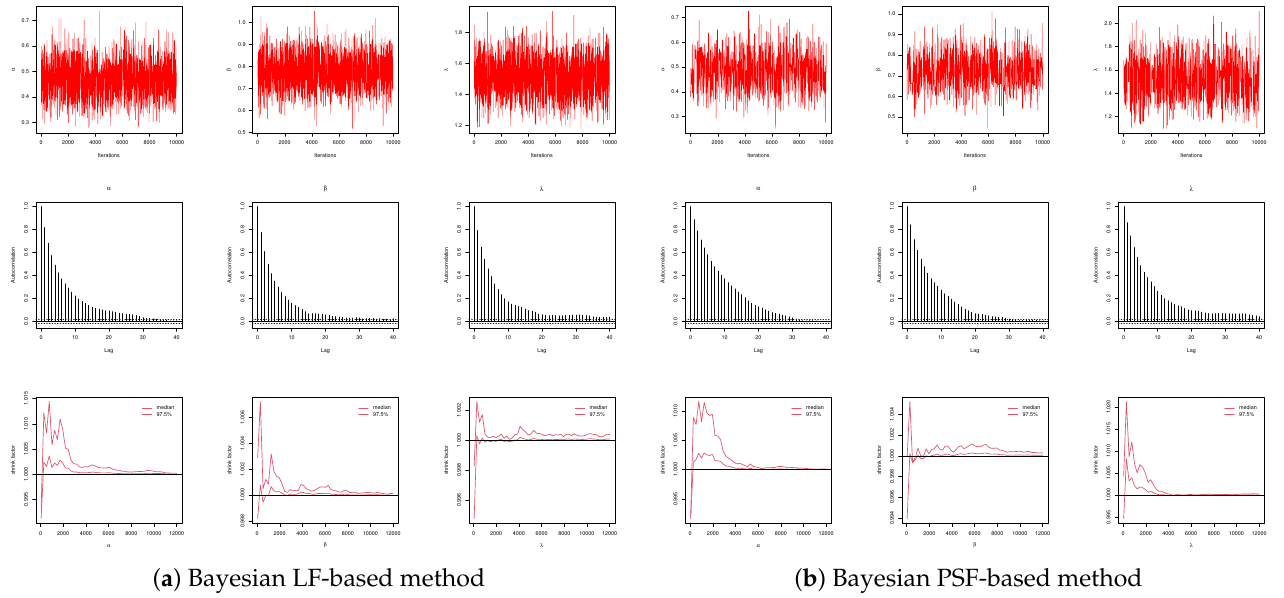
Figure 2. Trace ( top ), autocorrelation ( center ) and BGR diagnostic ( bottom ) plots for MCMC draws of α , β , and λ in Monte Carlo simulation.